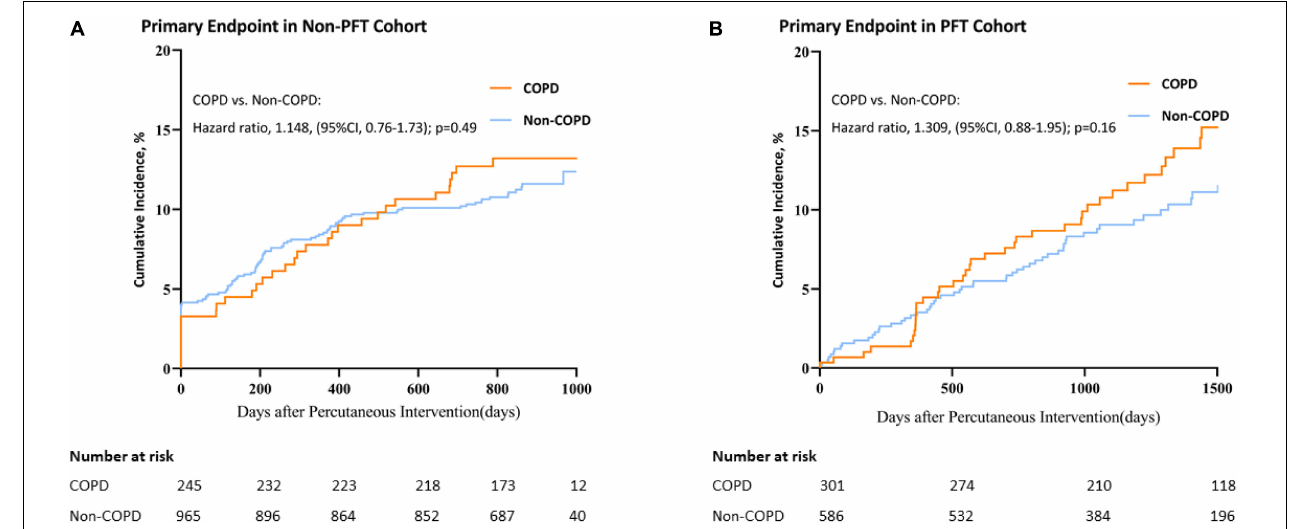
FIGURE 2 | Kaplan–Meier curves for primary end point in the non-PFT and PFT cohorts. Plot of Primary end point Incidence for COPD vs. non-COPD. (A) Primary end point in the non-PFT Cohort; (B) Primary end point in the PFT cohort. CI, confidence interval.